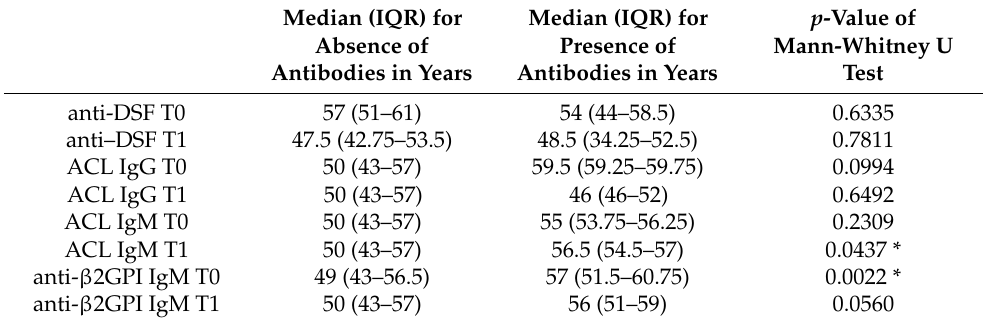
Table 4. The presence of anti-DFS antibodies, ACL, and anti- β 2GPI antibodies according to age. Qualitative statistically significant results included age vs. ACL IgM T1 and age vs. anti- β 2GPI IgM T0.